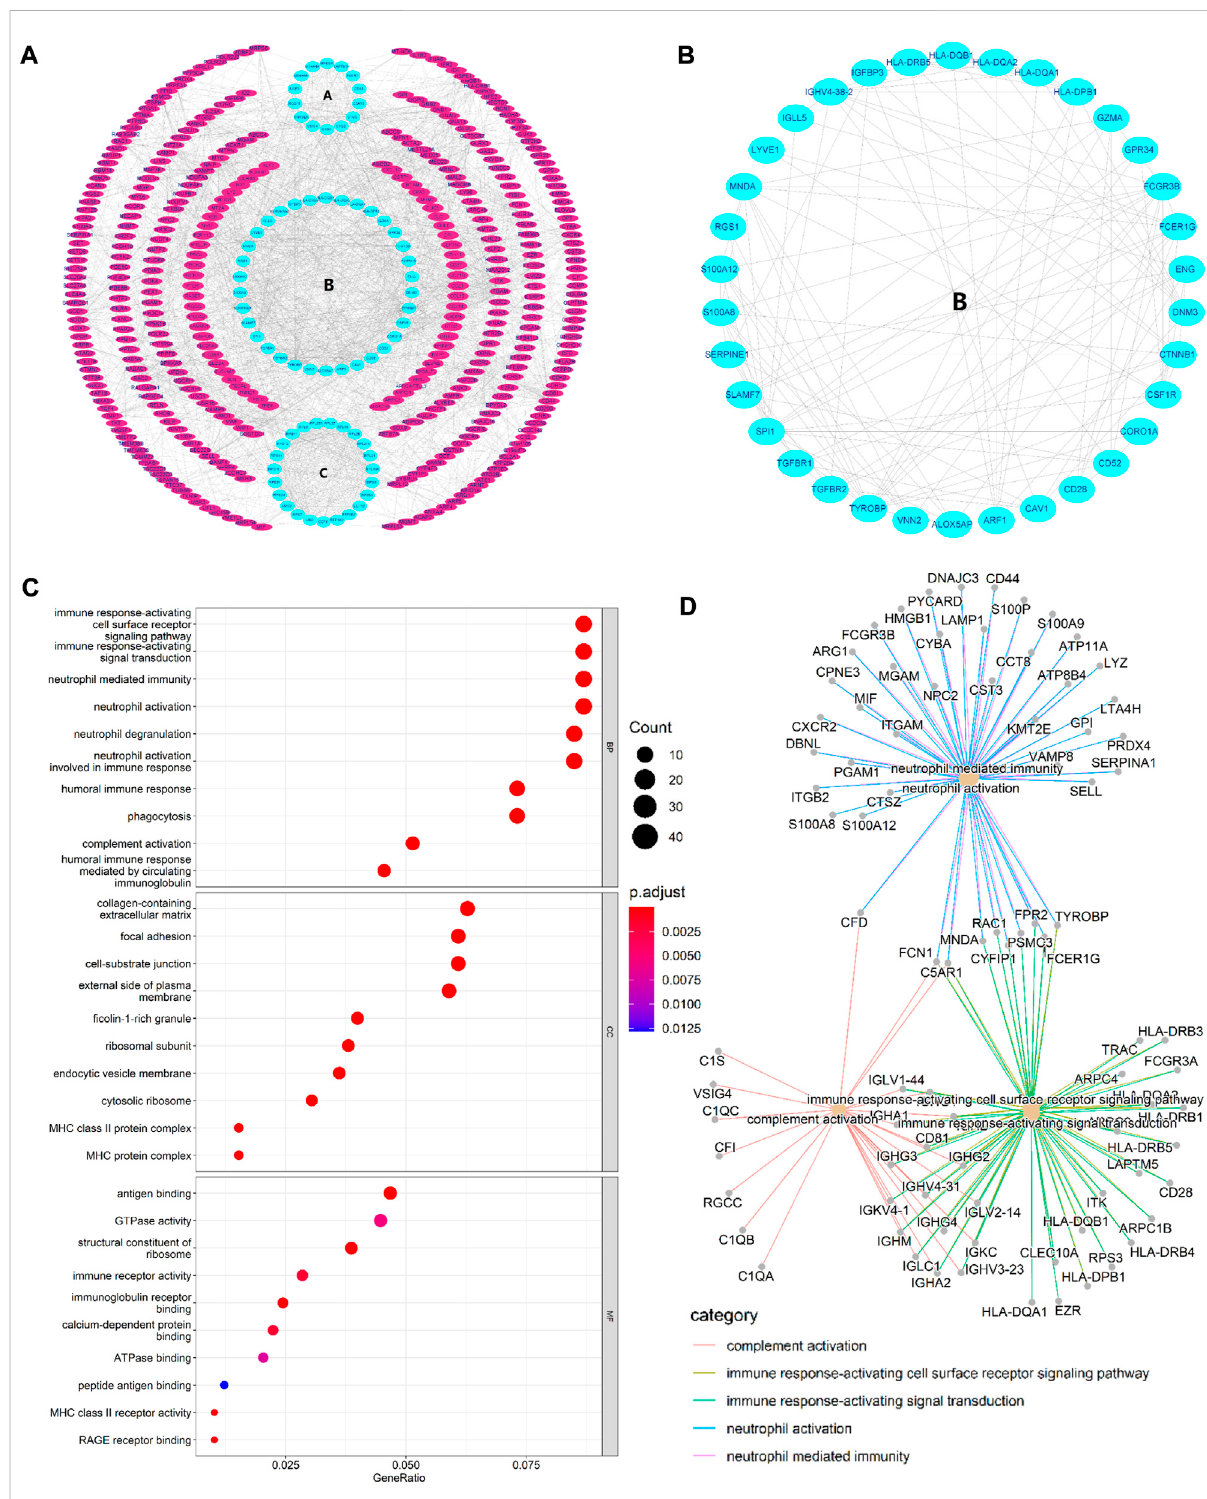
FIGURE 2 (A) PPI network. Thethreeinnermostcircles representthetop threecore subnetworks (A – C) .Inthenetwork,each noderepresents aDEG,and theedgesrepresentthecorrelationbetweenthenodes.Ingeneral,themoreedgesanodehad,thegreatertheroleofthatnode. (B) This mapshows thecoresubnetwork (B) .Eachnoderepresentsahubgene,andtheedgesrepresentthecorrelationbetweenthenodes.Ingeneral,themoreedgesa node had, thegreater the role of that node. (C) Top 10 GO enrichment results. The horizontal axis represents the gene ratio, i.e., theratio of the number of DEGs to number of total genes. Dot size is proportional to the gene ratio, and dot color from blue to red that the adjusted p value is smaller. (D) Association among the top fi ve immune-related biological processes was identi fi ed by analyzing co-enriched